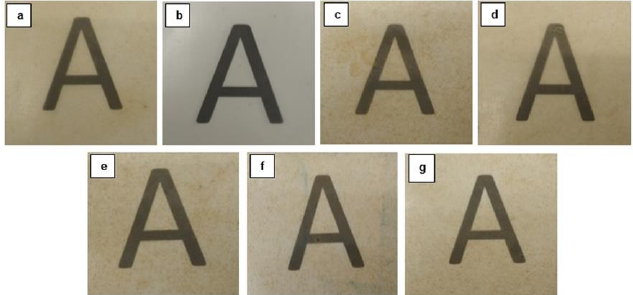
Figure 4. Visual aspect of the thermo-compressed films made of poly(3-hydroxybutyrate) (PHB), poly(3-hydroxybutyrate- co -3-hydroxyvalerate) (PHBV), and rice husk flour (RHF): ( a ) PHB / RHF; ( b ) PHB / PHBV; ( c ) PHB / PHBV5 / RHF; ( d ) PHB / PHBV10 / RHF; ( e ) PHB / PHBV20 / RHF; ( f ) PHB / PHBV30 / RHF; ( g ) PHB / PHBV50 /